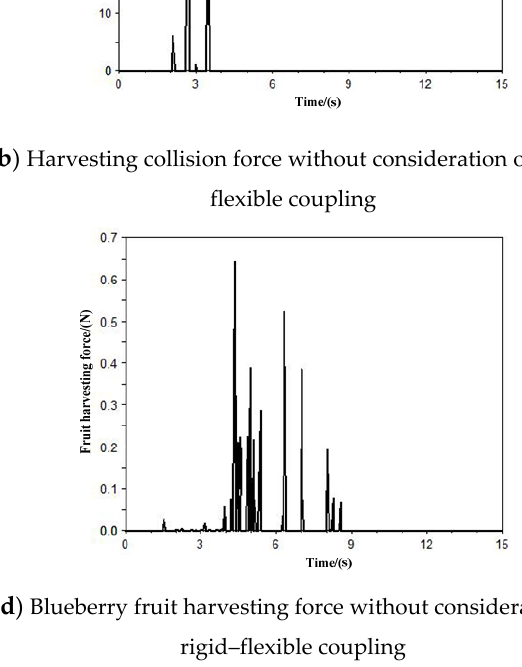
Figure 14. Comparative analysis of harvesting collision force between the harvester and the blueberry plants.